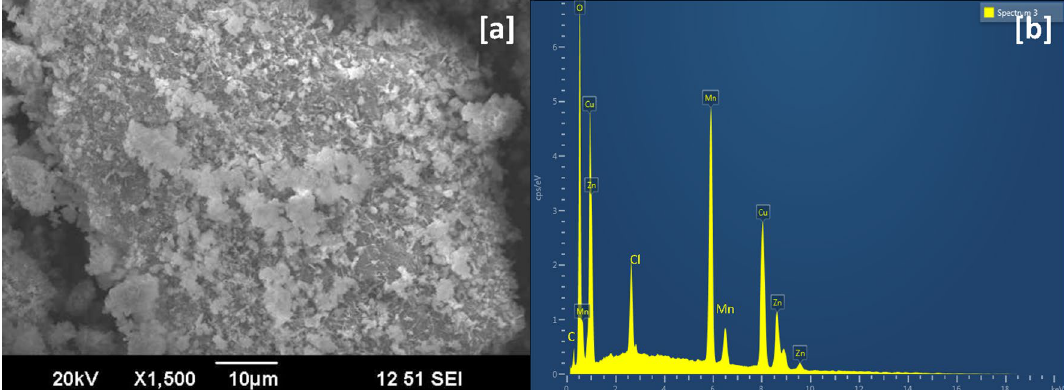
Figure 4. ( a ) SEM micrograph and ( b ) EDAX spectrum of CuO/Mn 3 O 4 /ZnO.